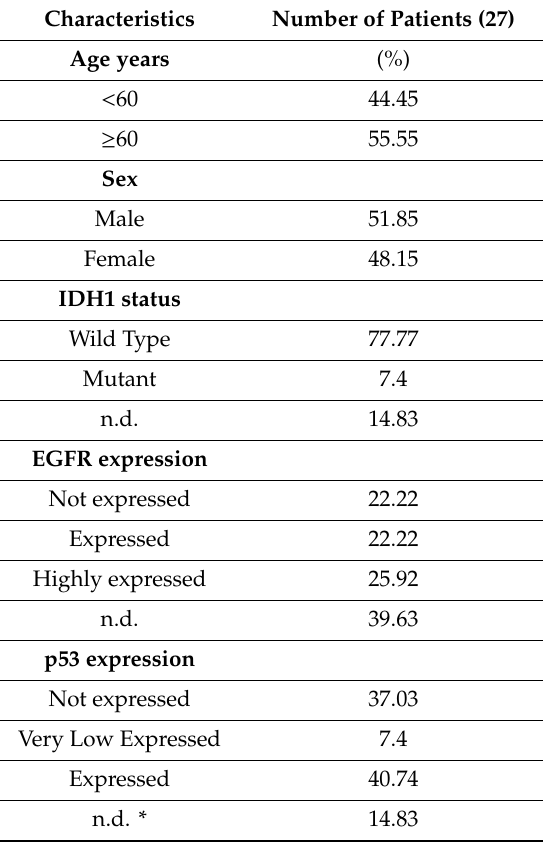
Figure 2. MEX3A expression is up-regulated in GB specimens. ( A – C ) Quantitative real-time PCR (qRT-PCR) analysis of MEX3A , RNF122 and MEX3C gene expression in GB samples described in Table 1 compared to corresponding paratumor tissues. Data are normalized to endogenous GAPDH and HPRT controls. Mean ± SD; * p < 0.05; ** p < 0.01; *** p < 0.001 calculated with two-sided Student’s t-test. Table 1. Characteristics of 27 high-grade GB